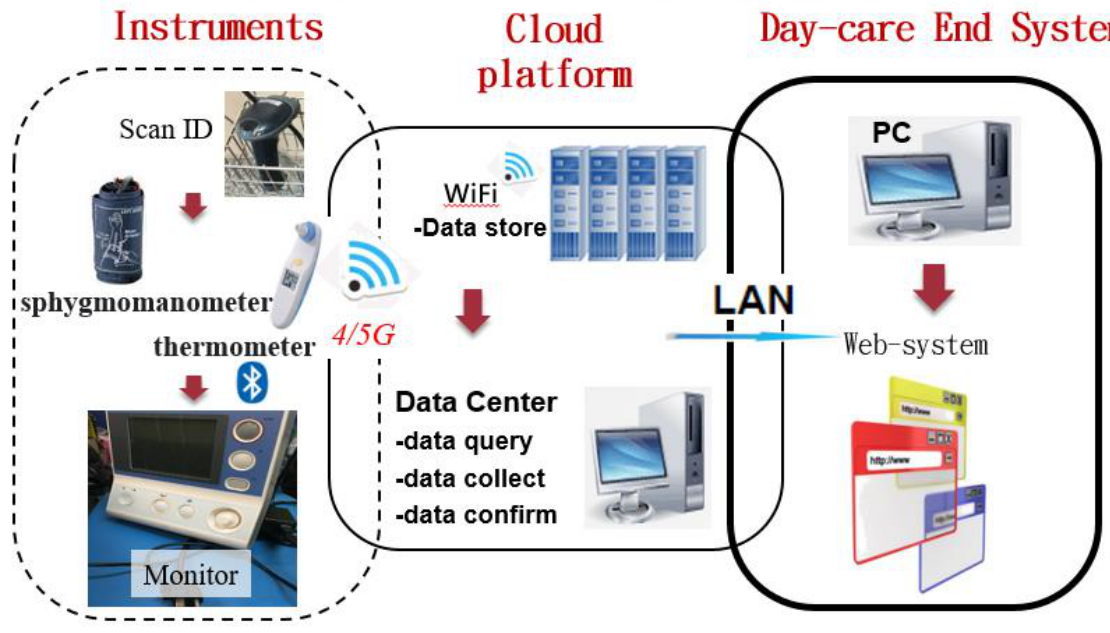
Figure 2. The transmission of biometric data. To integrate the network architecture for health, the frontend physiological signal monitoring system can be transmitted over Bluetooth and Wi-Fi through cellphone and notebook intermediary service platforms to integrate the processing of physiological in- formation acquired from the frontend sensing signal. The captured physiological signal is transmitted over the service platform of the network system to the database in a health- care center for storage. As for backend analytical processing, judgments and emergency notifications are referred to the healthcare institute and hospital professionals for analysis and judgment, which can reduce the reporting work for caregivers. Human resources can be utilized efficiently by applying the scale to evaluate chronic cases of mental